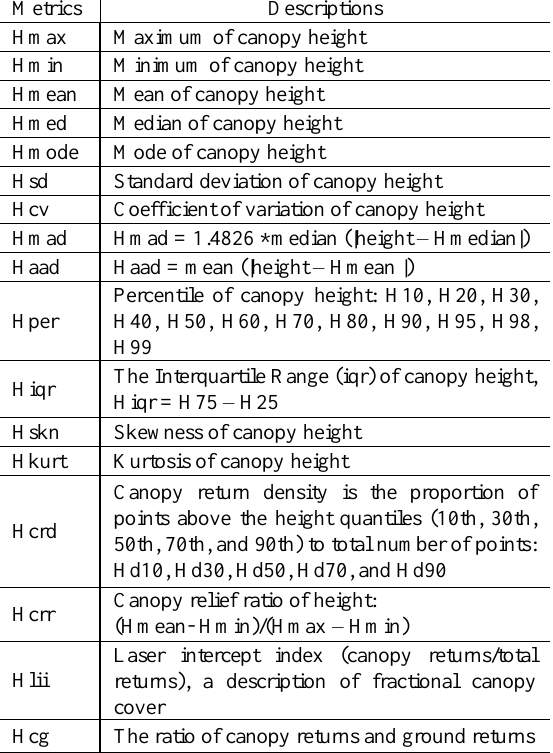
Table 2 List of canopy structure metrics derived from UAV- LiDAR and RGB photogrammetry-based point cloud.